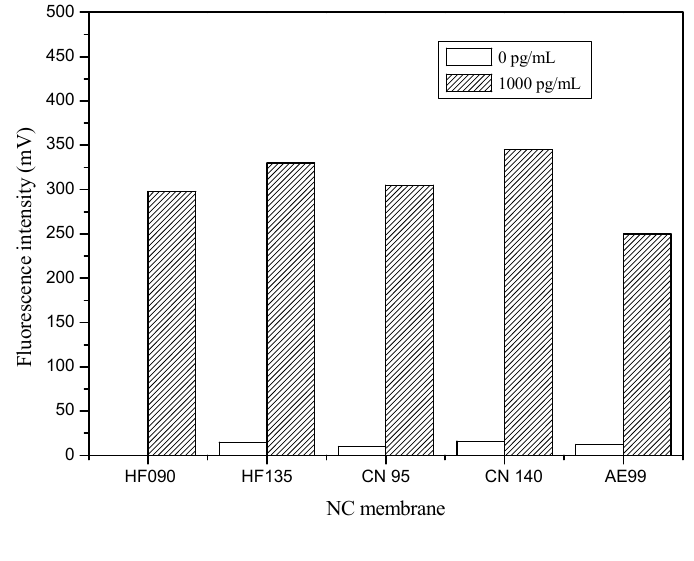
Figure 5. Responses at T lines on five different NC membranes (CN 95, HF 090, CN 140, HF 135, AE